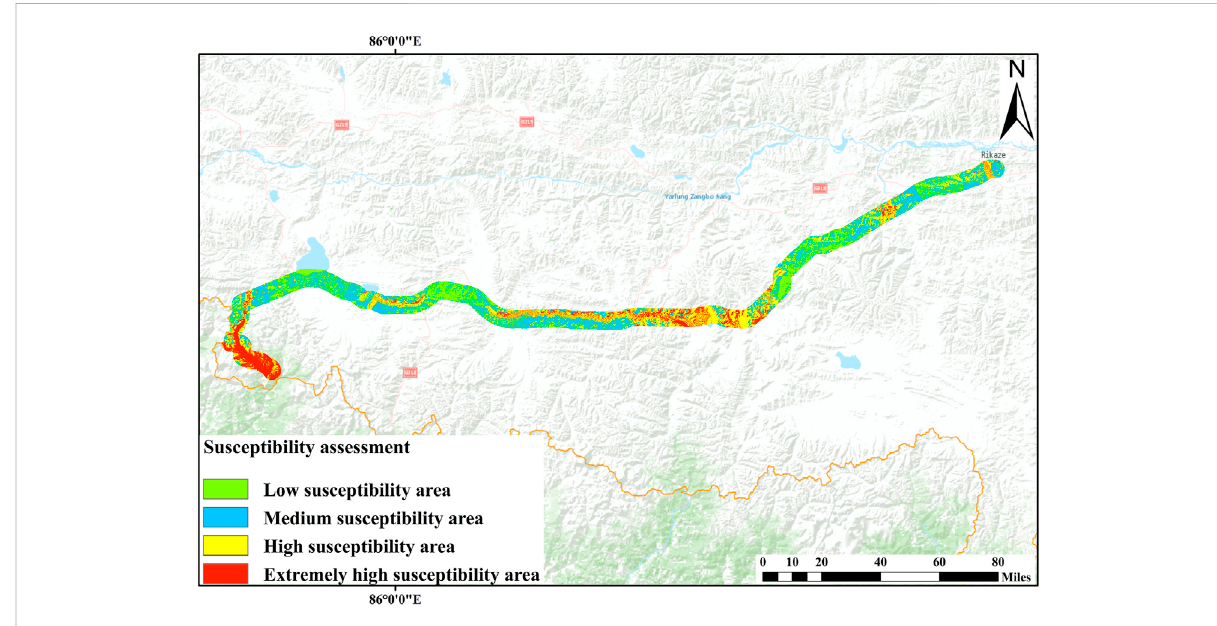
FIGURE 14 Susceptibility zoning map of engineering disturbance disasters along China – Nepal